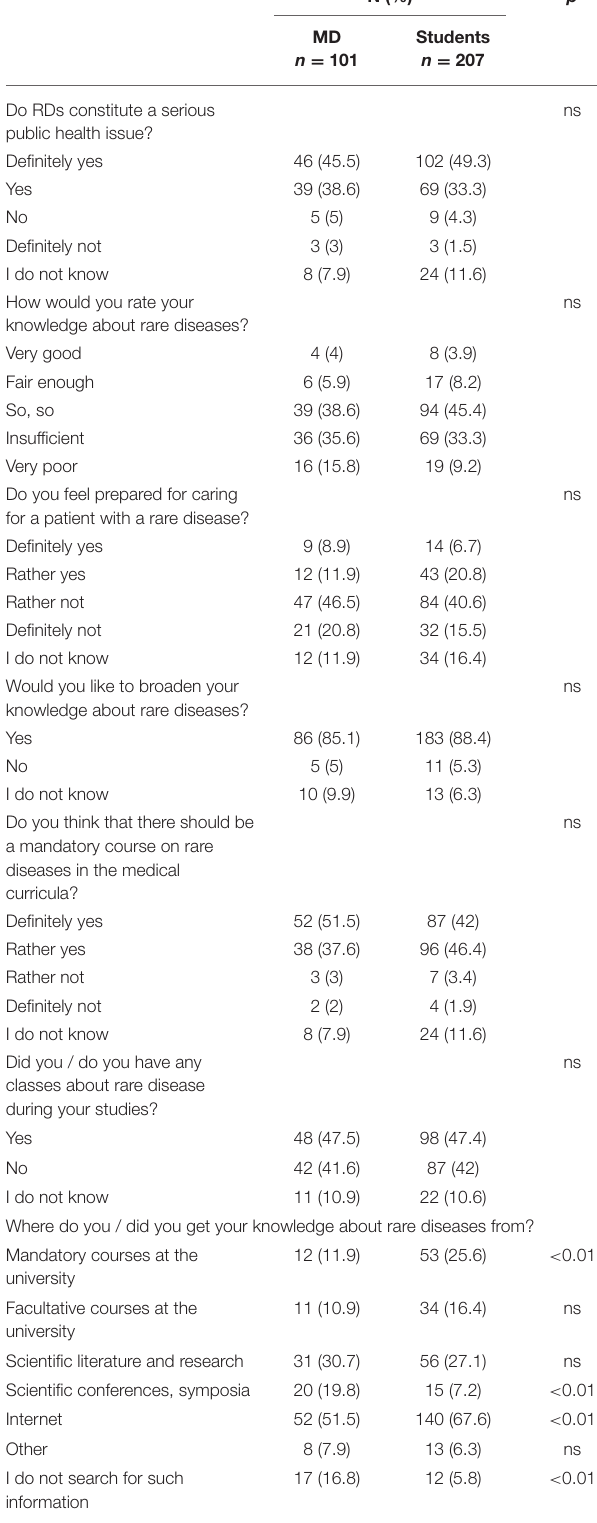
TABLE 4 | Respondents knowledge about the healthcare system for RD patients in RoK.